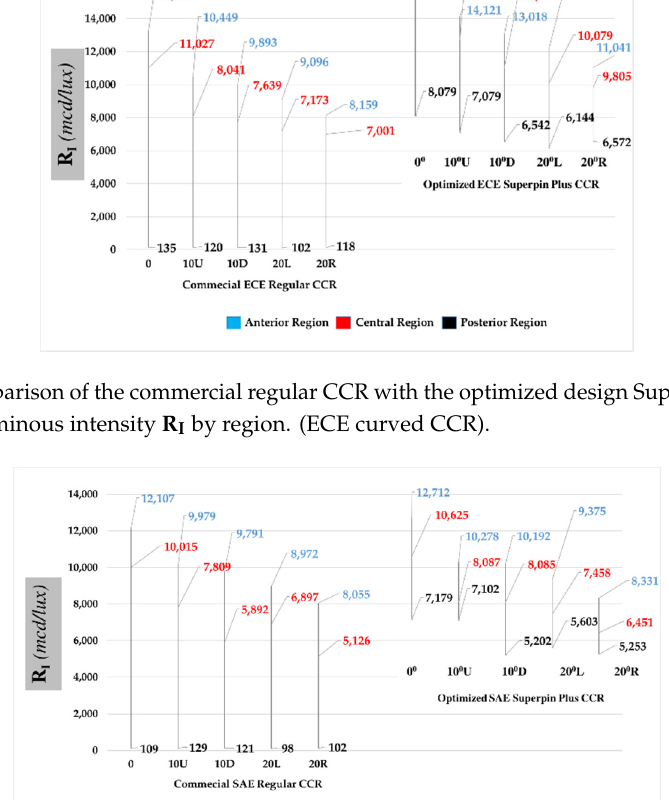
Figure 21. Comparison of the commercial regular CCR and the optimized design SuperPin Plus CCR’s coefficient of luminous intensity R I by region. (SAE curved CCR).